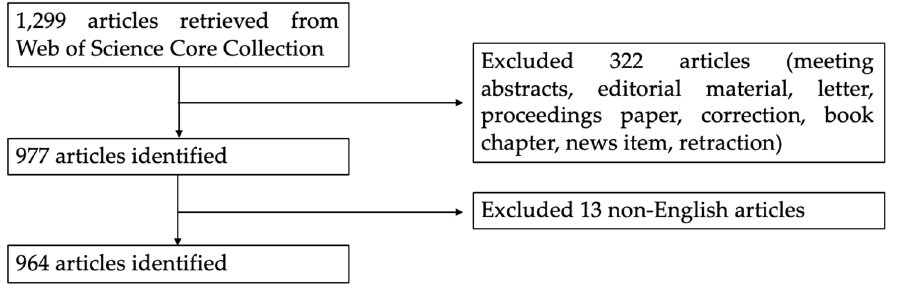
Figure 1. A flowchart representing retrieval strategies for chronic traumatic encephalopathy (CTE) articles from the Web of Science Core Collection (WoSCC) database and the inclusion criteria for the study.